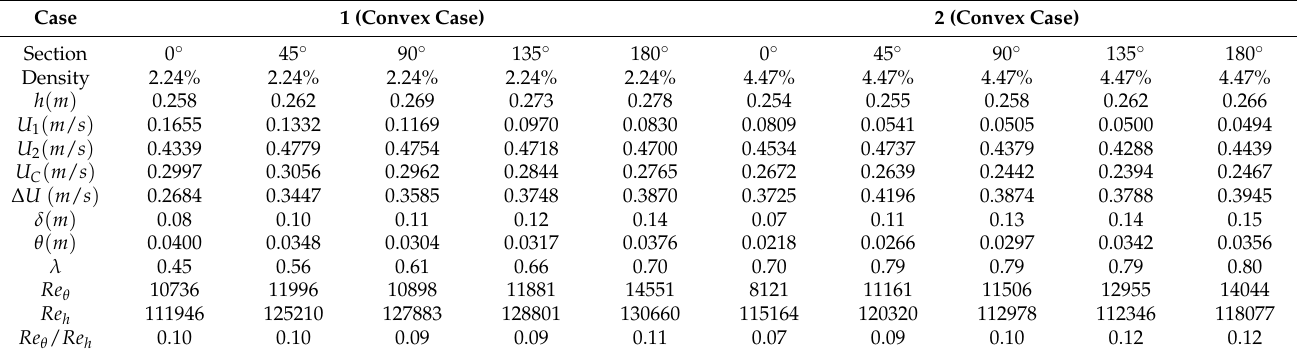
Table 1. Results of the